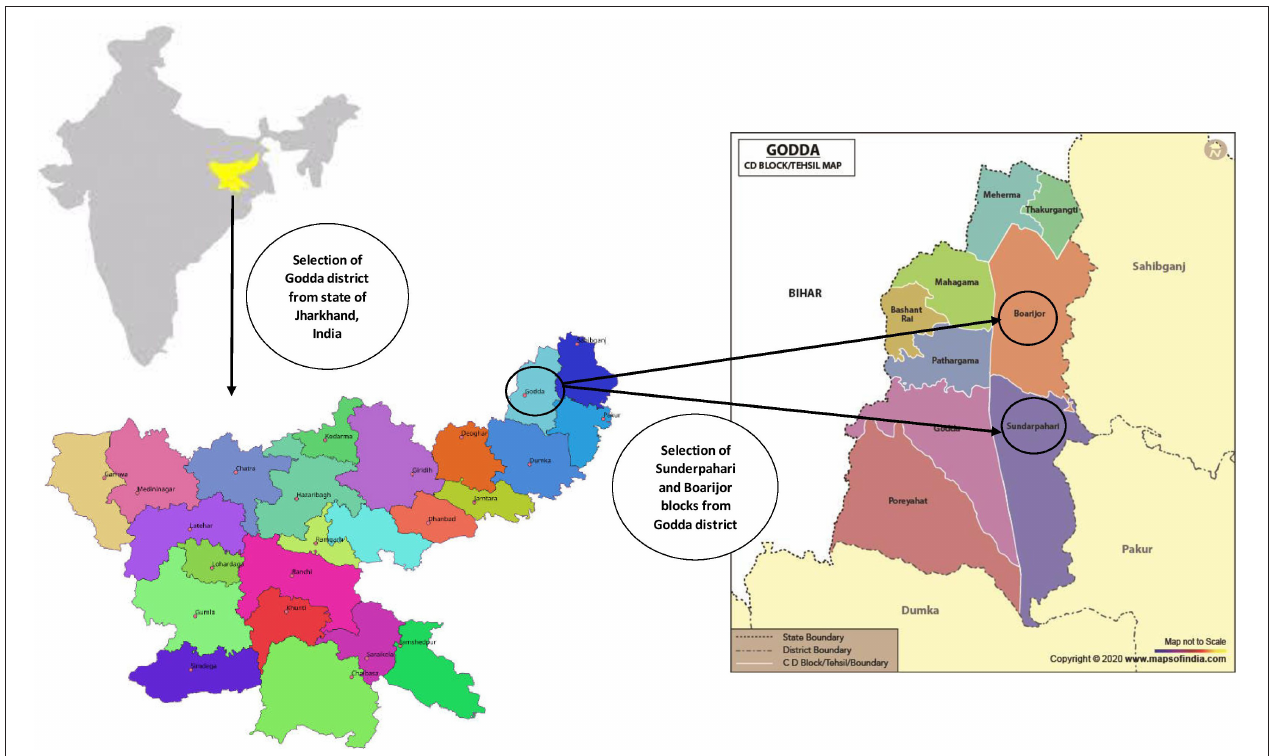
FIGURE 1 | Study landscape in Godda district of Jharkhand, India.